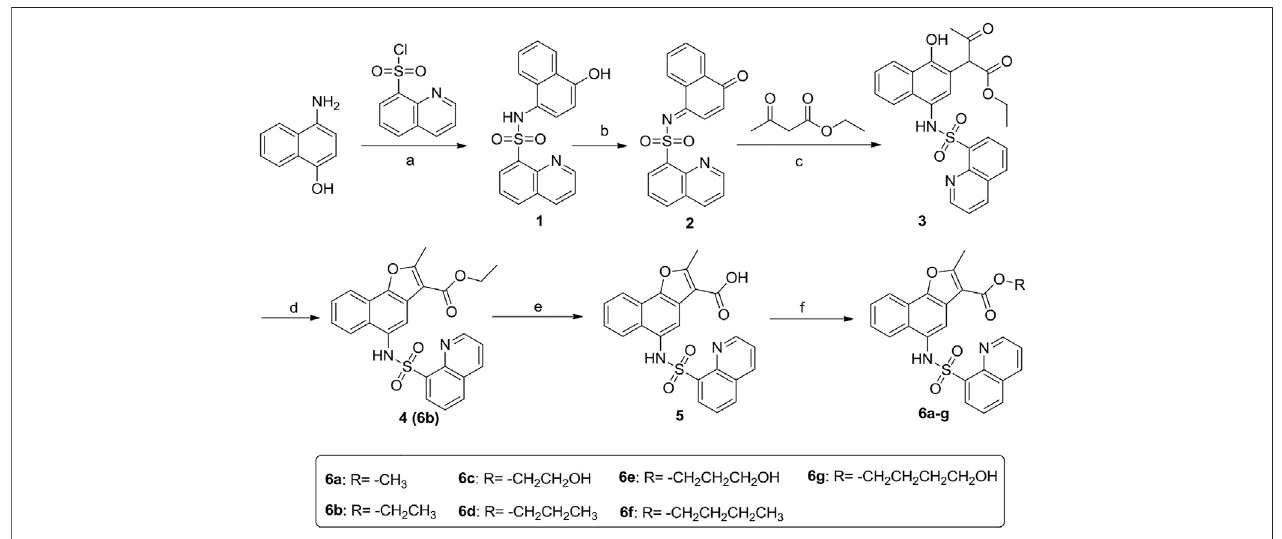
FIGURE 2 | (A) Crystal structure of human SIRT1 that is composed of catalytic domain (CD) and N-terminal domain (NTD), and the latter is responsible for the binding of SIRT1 activators. (B) Key residues for activator ’ s binding on the NTD of SIRT1. (C) Work fl ow of the molecular docking-based virtual screening.